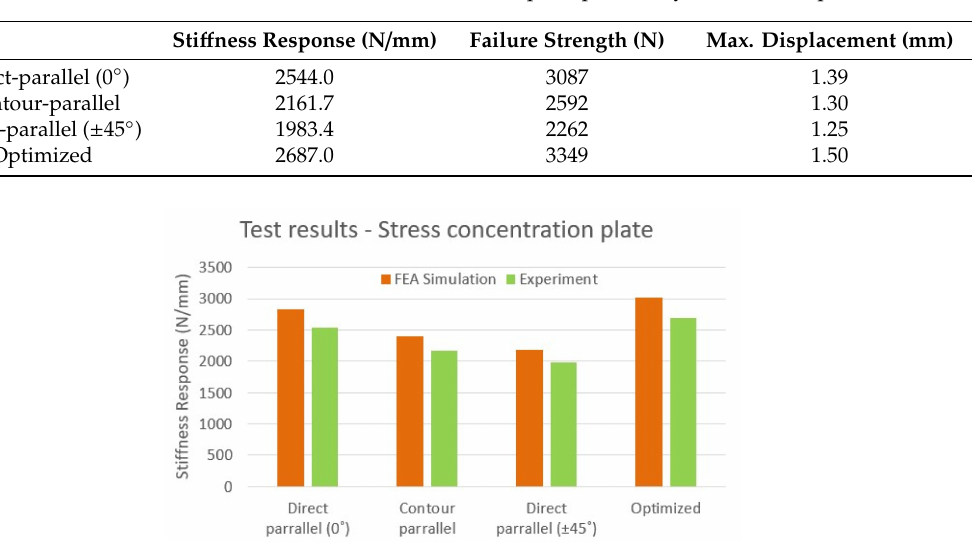
Figure 22. ( a ) Tensile test and ( b ) test result of stress concentration plate. Table 3. Tensile test results of stress concentration plate printed by various tool-paths.